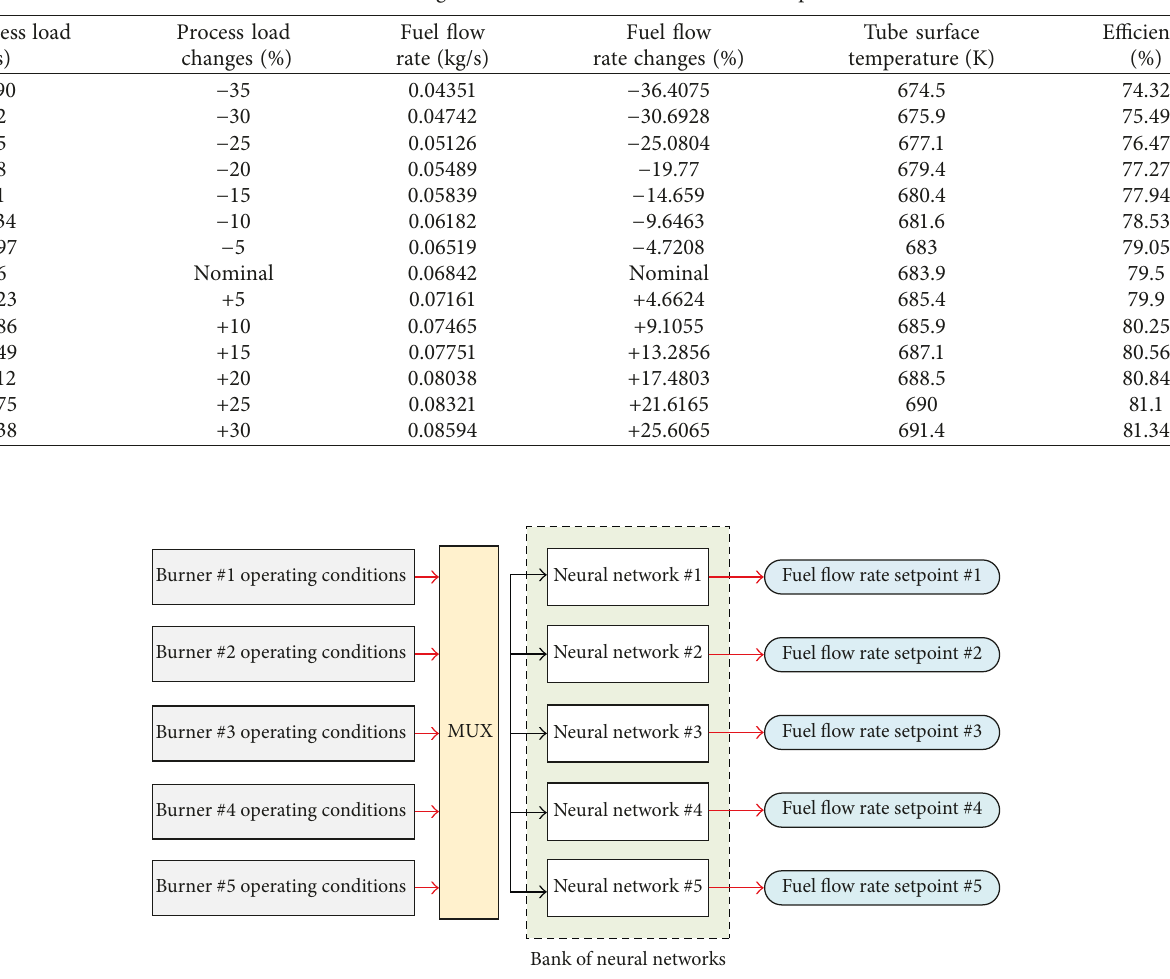
Figure 4: Structure of the neural network